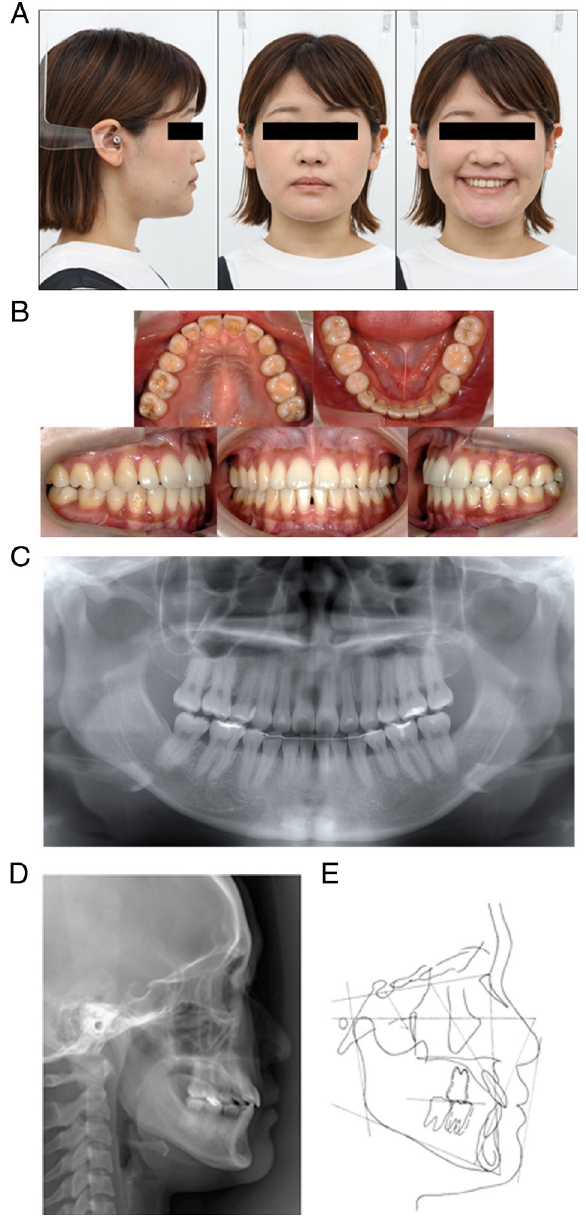
Figure 5. After retention photographs and radiographs: (A) facial photo- graphs, (B) intraoral photographs, (C) panoramic radiograph, (D) lateral cephalometric radiograph and (E) lateral cephalometric